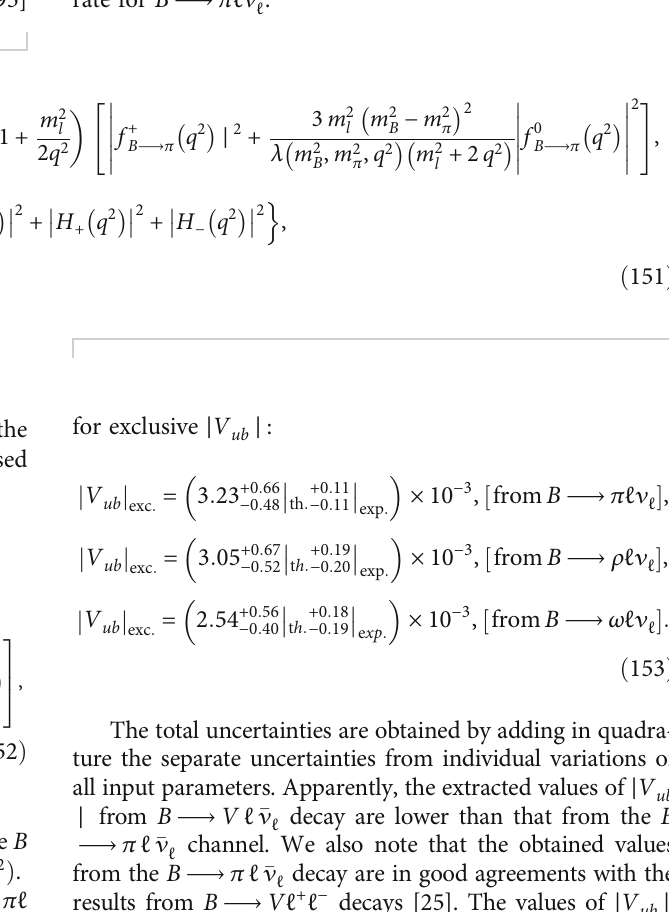
ð 0 Þ and the corresponding z -expansion shape parameters b +,0 B ⟶ π